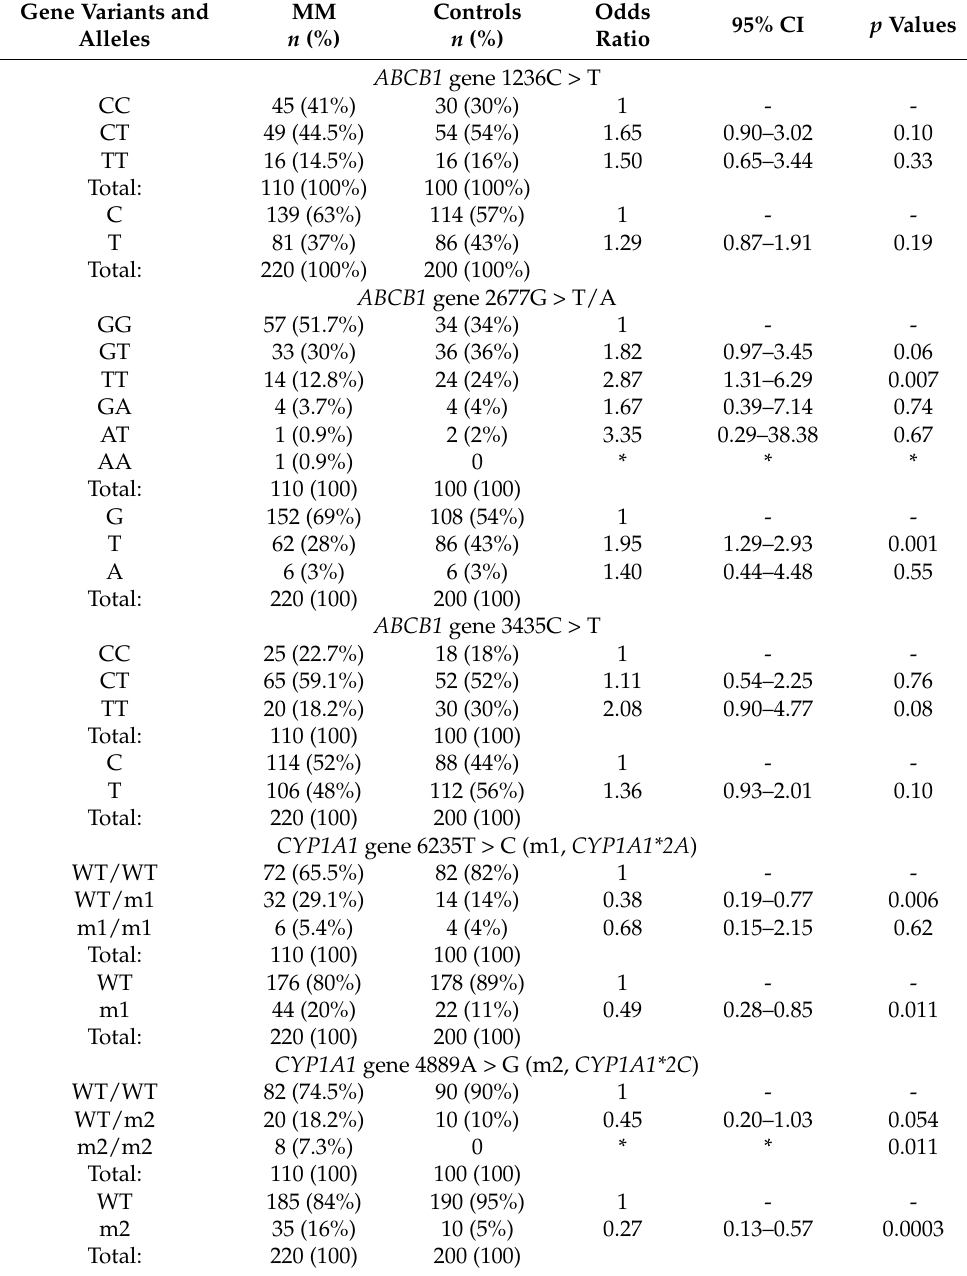
Table 3. The comparison of allele frequency and distribution of ABCB1 and CYP1A1 variants among MM patients and